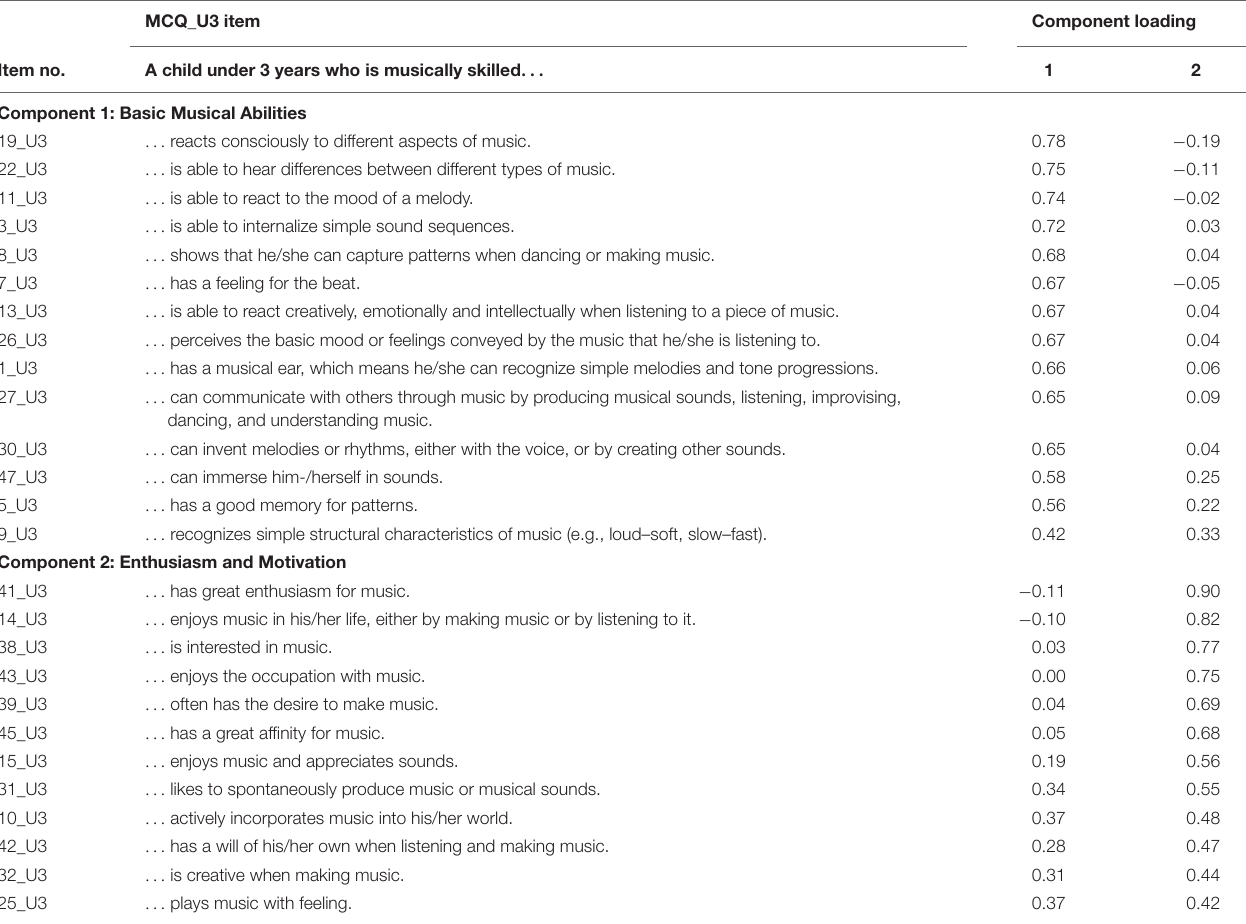
TABLE 5 | Short scale of the Musical Infant/Toddler Questionnaire grouped by components. MCQ_U3 item Component loading Item